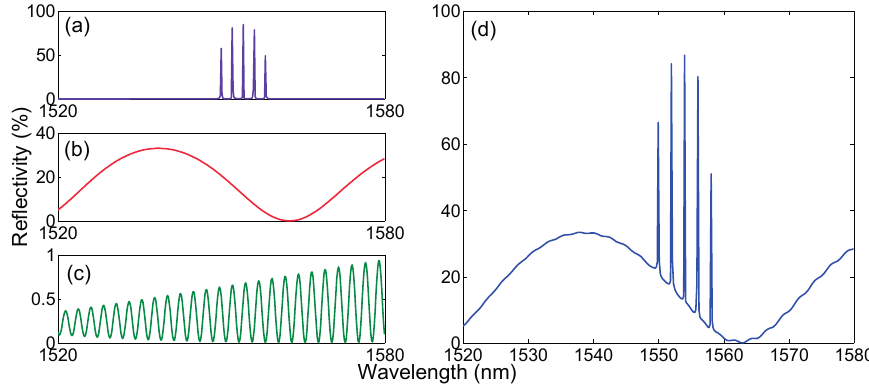
Figure 14. Spectrum of a multiple-FBG/FPI sensing system, used as benchmark for evaluation of the KLT eigenvalue filtering. The system is the combination of three sensing units: ( a ) an array of FBGs, equally spaced; ( b ) a highly reflective FPI with short cavity length; ( c ) a low-finesse FPI with long cavity length. The three spectra are combined, with additive Gaussian noise, to obtain the overall spectrum ( d ).